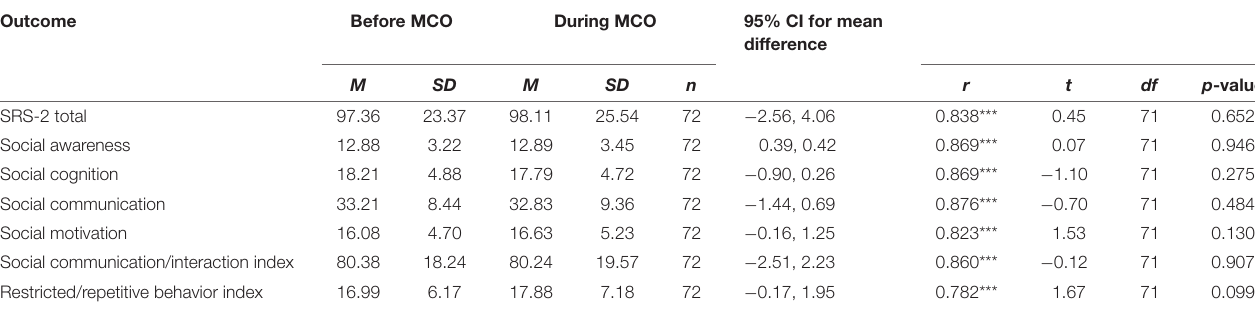
TABLE 4 | Mean and standard deviation and paired sample T -test for social responsiveness scales-2 in ASC group. Outcome Before MCO During MCO 95% CI for mean difference M SD M SD n r t df p -value SRS-2 total